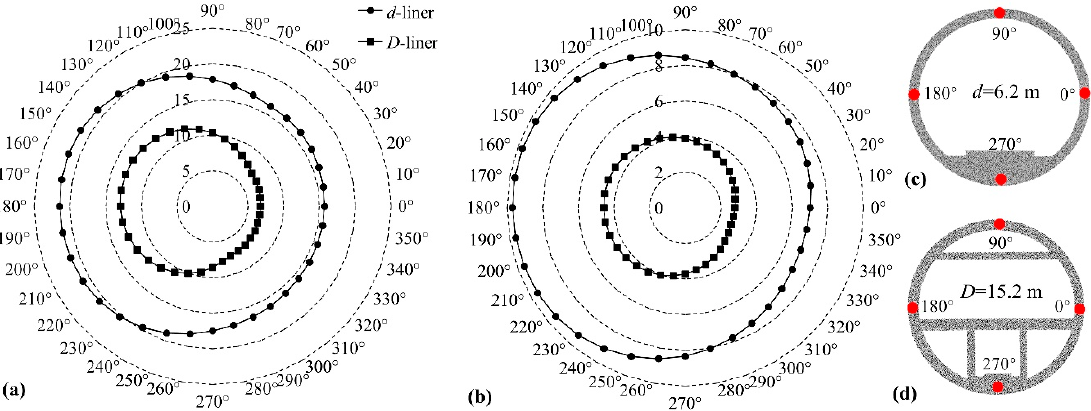
Figure 16. Comparison of resultant velocity of t2 and T2: ( a ) maximum value of resultant velocity; ( b ) average value of resultant velocity; ( c ) measurement points of t2; ( d ) measurement points of T2.